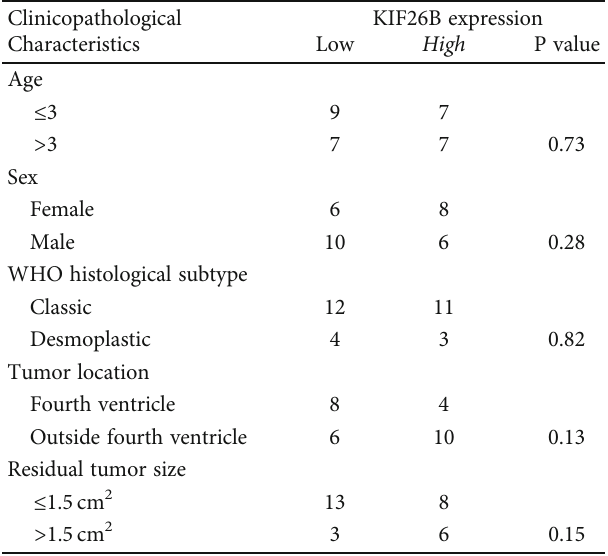
Table 1: Clinicopathological characteristics of patients with MB. Clinicopathological KIF26B